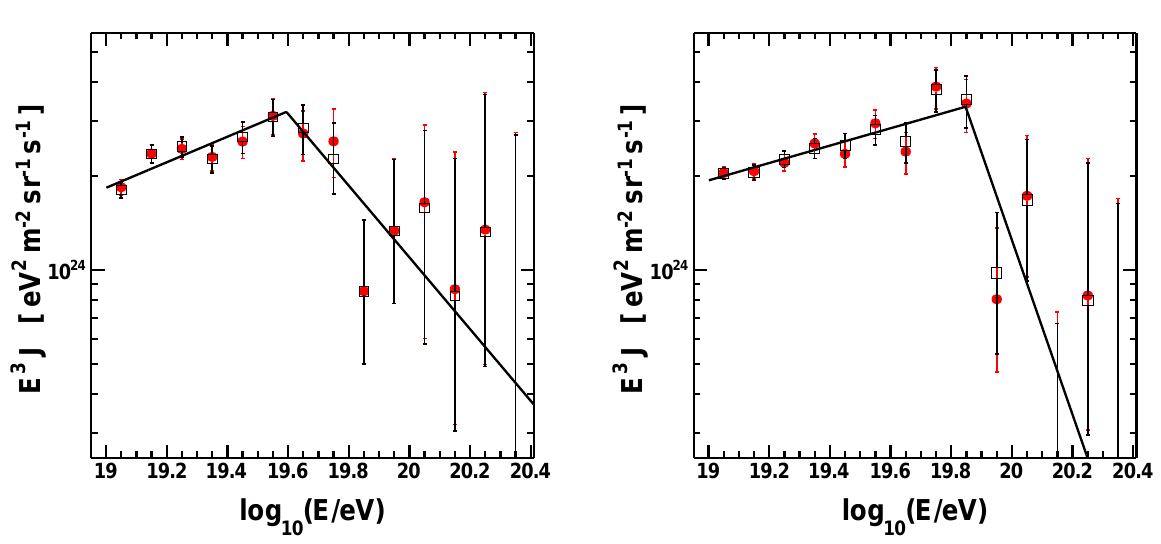
Figure 10. TA energy spectra calculated by the constant intensity cut method (red filled circles) and the traditional, Monte Carlo-based shower attenuation correction (open squares). The left panel is the comparison made in the Auger-TA common declination band, − 15 . 7 ◦ < δ < 24 . 8 ◦ , and the right panel shows the comparison for the higher declination band, 24 . 8 ◦ < δ < 90 ◦ .